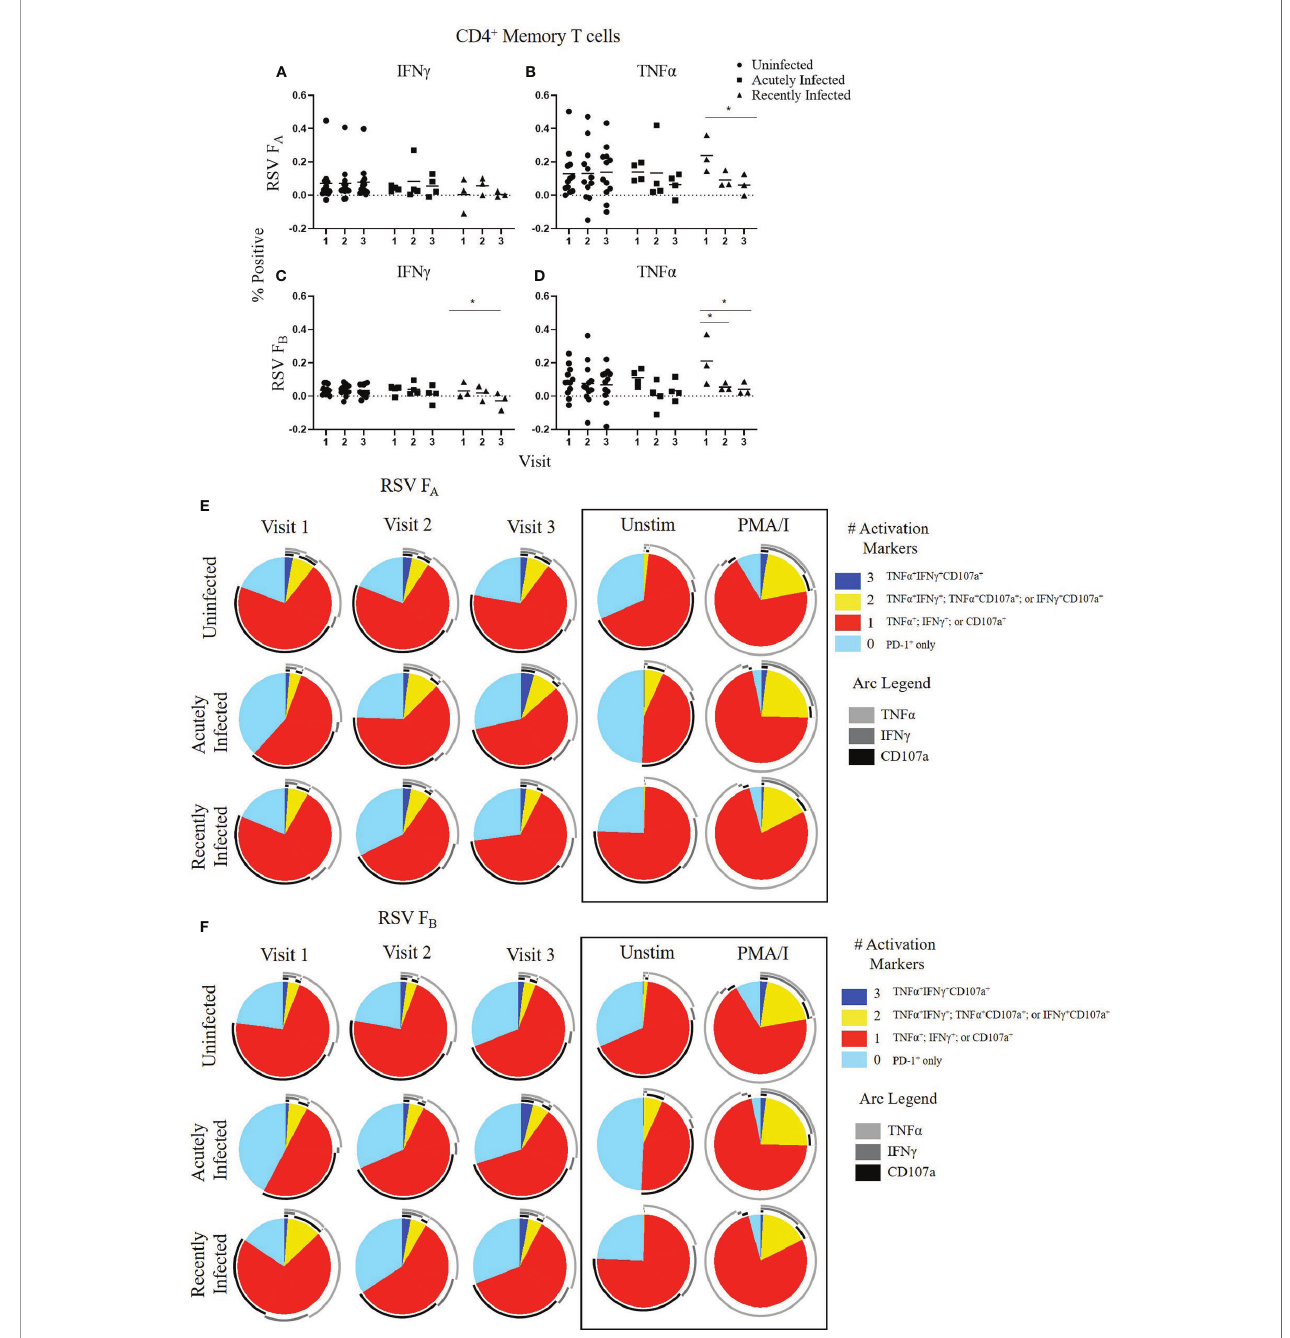
FIGURE 2 | CD4 + Memory T cellresponses to the RSVF protein peptide libraries byRSV infection statusand study visit. (A – D) Individual functional marker expression by RSVinfection status: uninfected( n = 12), acutely infected ( n = 4), andrecentlyinfected( n = 3).PBMCs were stimulated invitro with RSVF A (A,B) or RSVF B (C,D) F protein peptide libraries. Marker expression isshownas percentageof totalCD4 + memory T cells. symbol represents the response from a singleindividual. The thick horizontalbar indicates the mean of allresponses within each group at that visit. A signi fi cant pairwise comparisonofmean percentage difference between visits within a groupisdenoted bya thin horizontal bar with * P ≤ 0.05. (E, F) Polyfunctional CD4 + memoryT cellresponses to RSV F A or RSVF B protein peptide libraries as a function ofRSV infection status andstudy visit. Simpli fi ed Presentation of Incredibly Complex Evaluations(SPICE) analysis was performed for the identi fi cation of CD4 + memory T cellsexpressing multiple activation markers. Pie charts show the frequency inwhich PBMCs produced the variouscombinations ofthe activation markers CD107a, IFN g , andTNF a ; or expressed PD-1 alone. Background (determinedfromthe media-stimulated negative controls) was subtracted from allsamples andnegative values were setto zero. Surrounding arcs denote the speci fi c markersproduced by the cells ineach pie segment. Representative negativeand positive controlsacross all study visits are